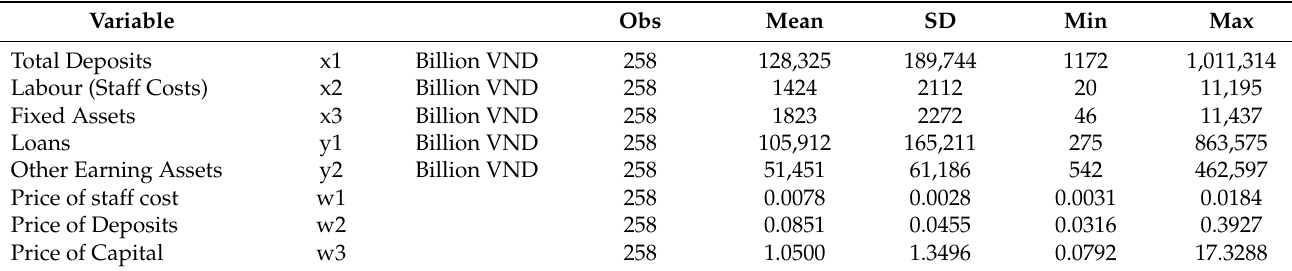
Table A5. Summary statistics of the financial data used to compute Vietnam bank efficiency